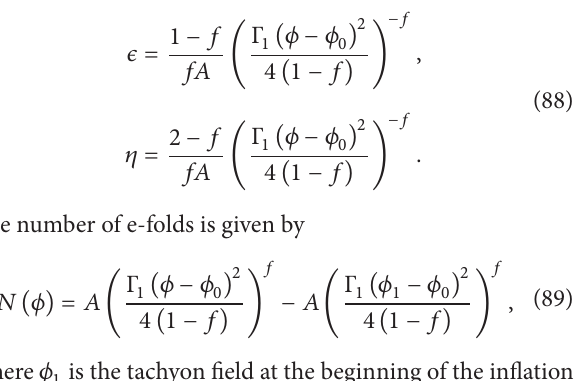
Figure3:InthisgraphweplotthetemperaturetoHubbleparameter ratio 𝑇/𝐻 in terms of the spectral index 𝑛 𝑠 . We can find best fit of warm inflation condition ( 𝑇 > 𝐻 ) with the Planck data.